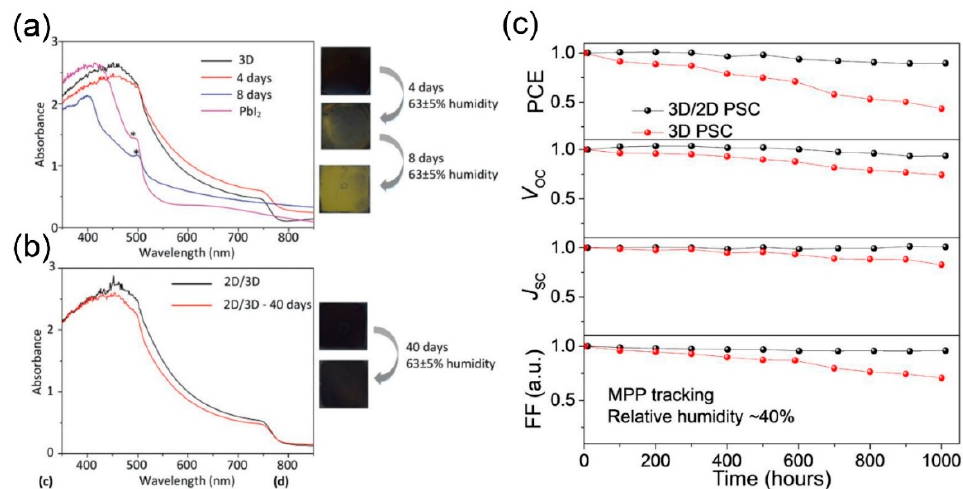
Figure 7. Effect of 3D/2D bilayered perovskite on the device’s long-term stability. Absorbance spectra and photo images of ( a ) 3D and ( b ) 3D/2D bilayered perovskite film as a function of aging time. Reprinted with permission from ref. 24 Copyright 2016 The Royal Society of Chemistry. ( c ) Long-term photovoltaic parameters of un-capsulated PSCs monitored under one sun illumination with a humidity (RH) of ~40% at maximum power point tracking. Reprinted with permission from Ref. [25] Copyright 2019 AAAS.